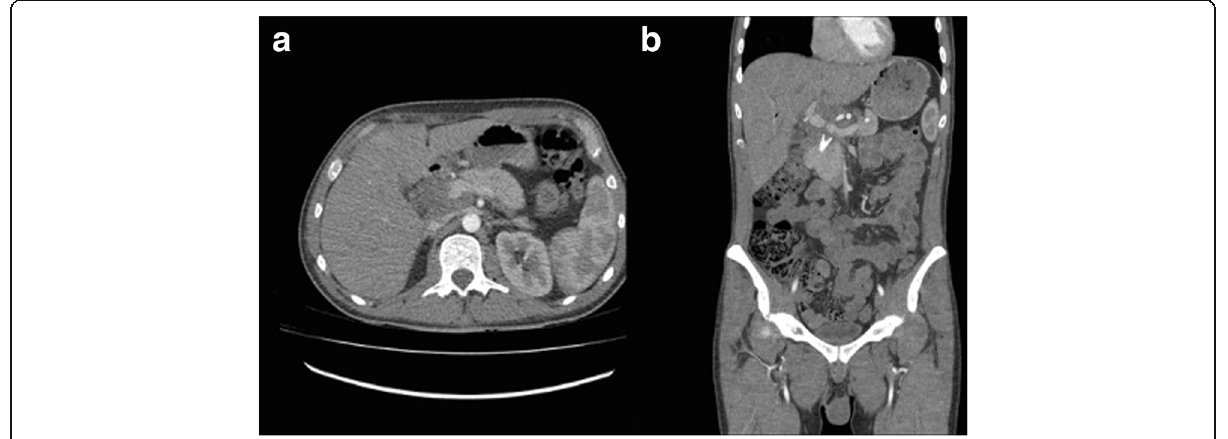
Fig. 3 Portal venous phase CT showing a main portal vein pseudoaneurysm closely related to the upper end of the biliary